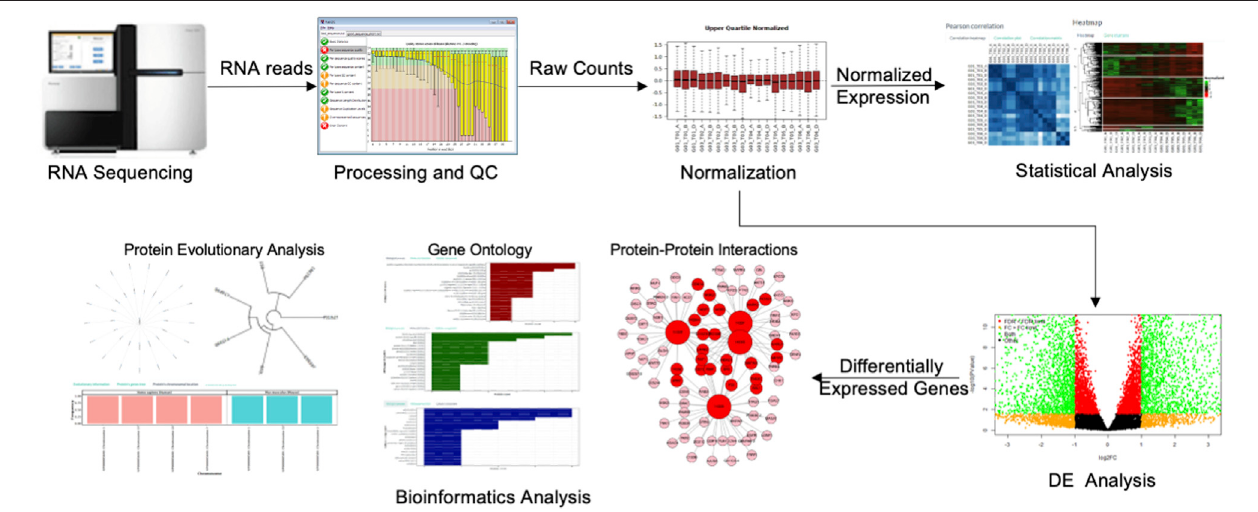
FIGURE1| The gene expression pro fi ling work fl ow. The RNA sequencer produces raw RNA read counts that are aligned on the cell ’ s genome and processed through the quality control (QC) steps. The raw read counts result from QC are next normalized and analyzed statistically to infer the differential gene expressions (DGEs) or other analyses such as Shannon Entropy, Correlations or PCA. Several bioinformatics analyses can also be performed on the list of DEG for functional inference.